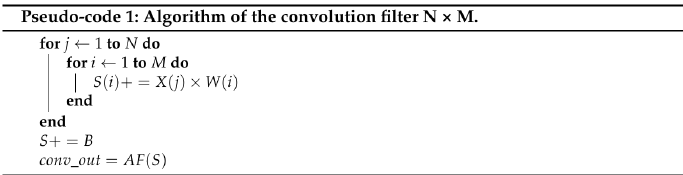
Figure 12. Algorithm of of the convolution filter N ×